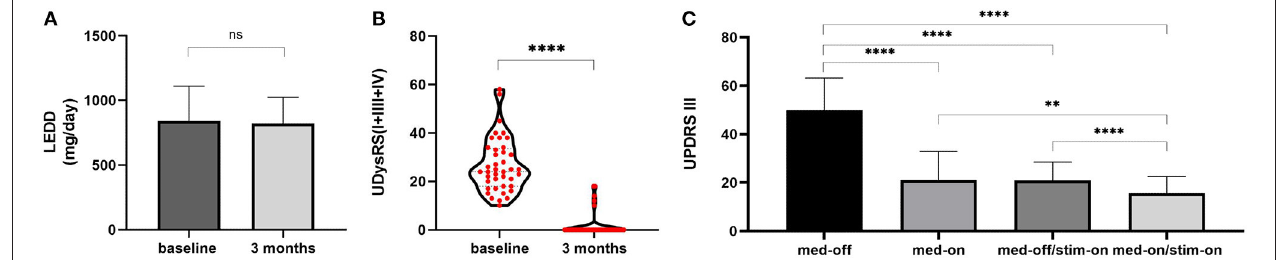
FIGURE 1 | LEDD changes and outcome of UDysRS and UPDRS-III. (A) LEDD: at baseline 844.6 ± 266.1 mg/day, at 3 months of follow-up 823.1 ± 201.5 mg/day. (B) Violin with plots showing UDysRS (I + III + IV) scores: 24 (10–58) at baseline to 0 (0–18) at 3 months of follow-up. (C) UPDRS-III: Med-off 49.95 ± 13.30, Med-on 21.03 ± 11.87 at baseline; Med-off/Stim-on 20.88 ± 7.68, Med-on/Stim-on 15.55 ± 7.11 at 3 months of follow-up. The values are presented as mean ± standard deviation or median (range). ****, P < 0.0001; **, P < 0.01; ns, non-significant; LEDD,levodopa equivalent daily dose; UDysRS, Unified Dyskinesia Rating Scale; UPDRS-III, Unified Parkinson’s Disease Rating Scale part